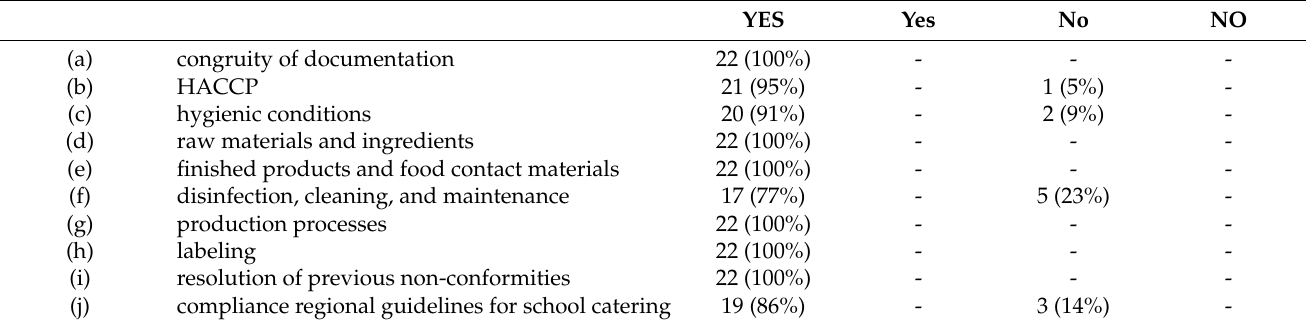
Table 3. OC—Hygienic–sanitary section (classified in 4 levels).